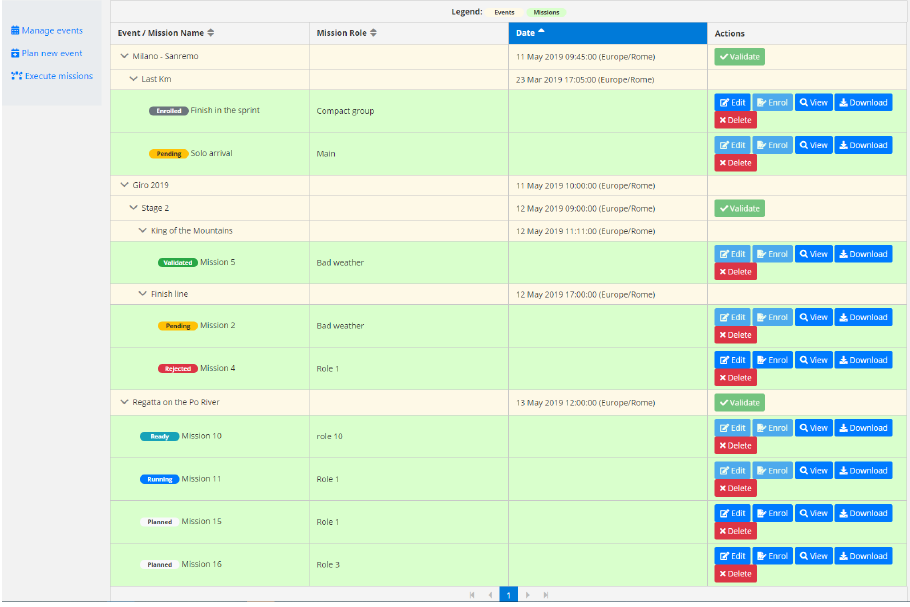
Figure 3. Example screenshot of the director’s home